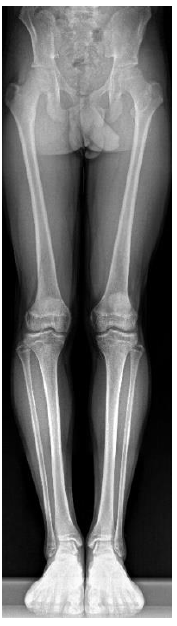
Figure 9. Long-format X-ray of the lower limbs showing a slight bilateral acetabular dysplasia of the hips due to a history of DDH (Developmental dysplasia of the hips). The centrum–collum–diaphysis angles are 132° on the right side and 134° on the left side.